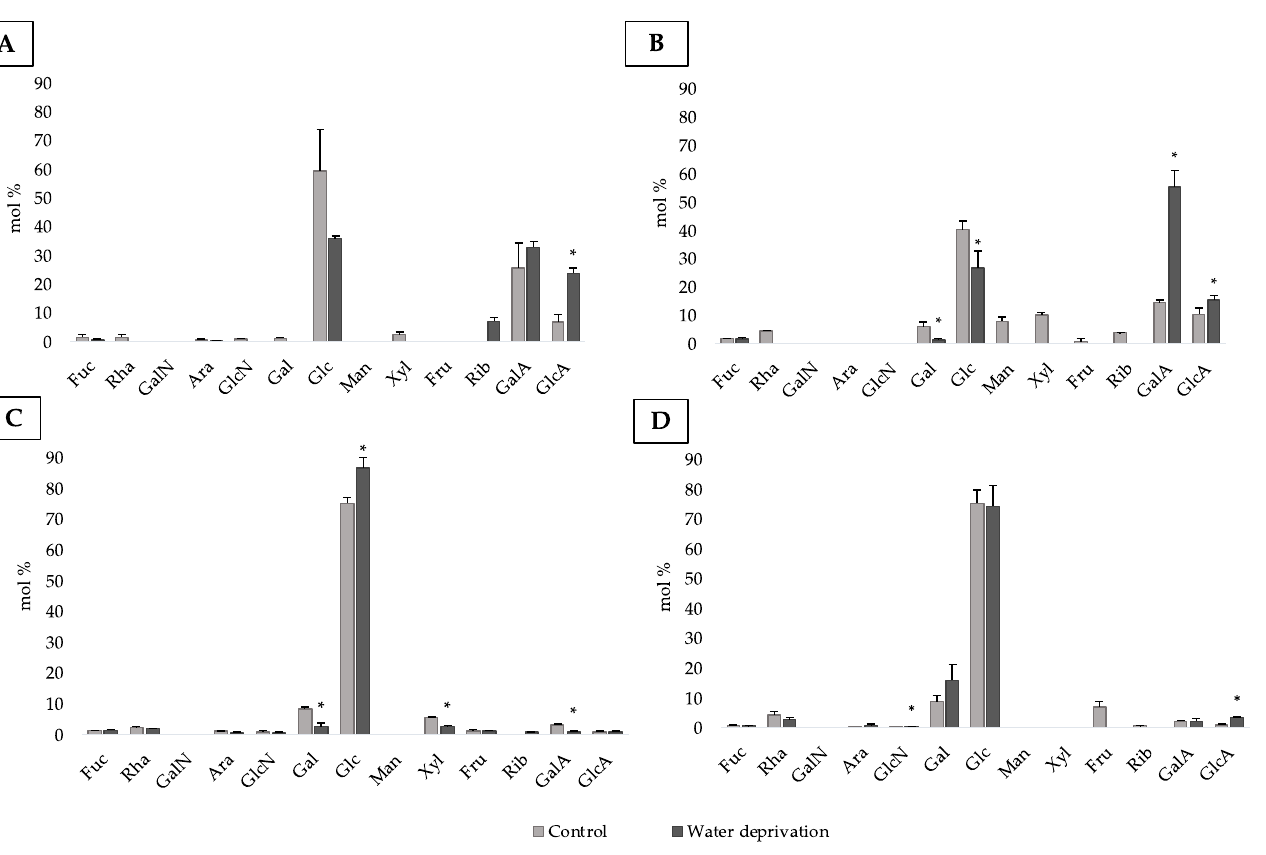
Figure 6. Monosaccharidic composition of the EPS extracted from biofilms: ( A ) RPS from P. ambiguum , ( B ) RPS from L. ohadii , ( C ) Sheath EPS, ( D ) G-EPS. Molar percentages (%) of single sugars are represented (expressed as moles of the single monosaccharide divided by the total amount of moles of monosaccharides in the EPS × 100). Symbol *, when present, indicates significant differences between the control and the water-deprived period in each monosaccharide. Fuc, fucose; Rha, rhamnose; GalN, galactosamine; Ara, arabinose; GlcN, glucosamine; Gal, galactose; Glc, glucose; Man, mannose; Xyl, xylose; Fru, fructose; Rib, ribose; GalA, galacturonic acid; GlcA, glucuronic acid.